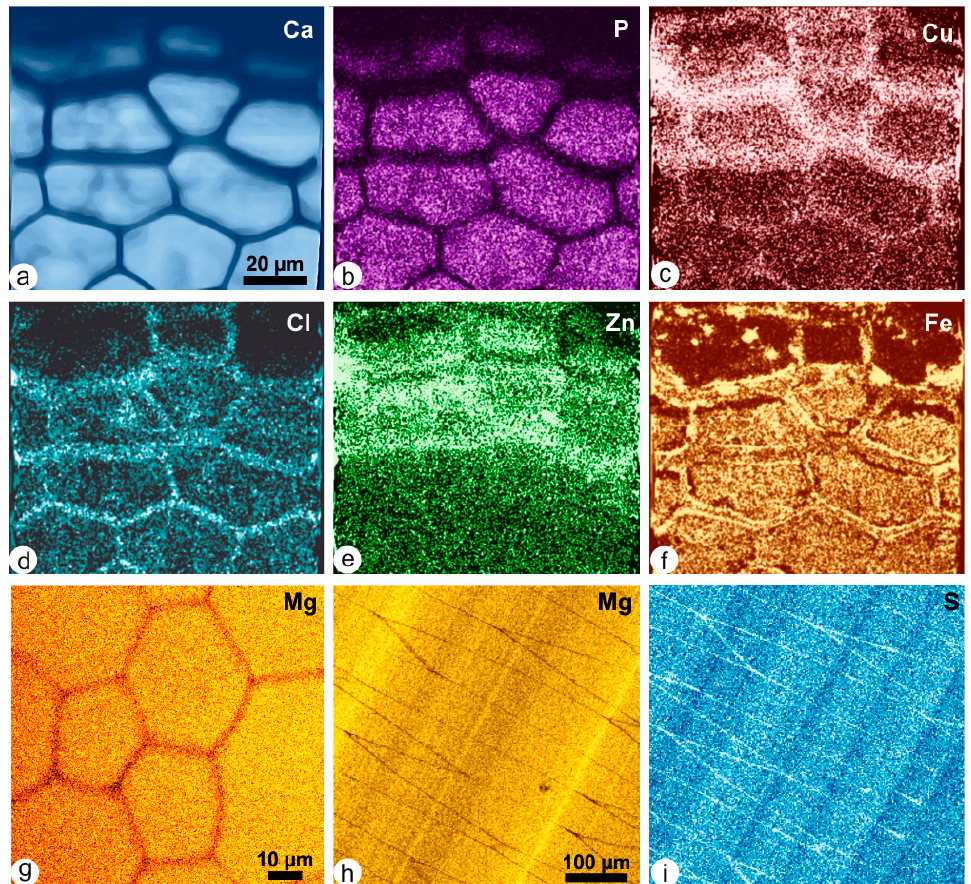
Figure 10. Elemental composition of the prismatic layer. ( a – f ) X-ray fluorescence maps of Pinna muricata ). ( g ) Electron Probe Micro Analysis map of a polished transverse section showing the inter-prismatic membranes are poor in Mg ( Pinna nobilis ). ( h , i ) Longitudinal sections of Pinna nobilis showing that the Mg and S contents of the prisms are not homogeneous, and that chemical growth lines are not superimposed.